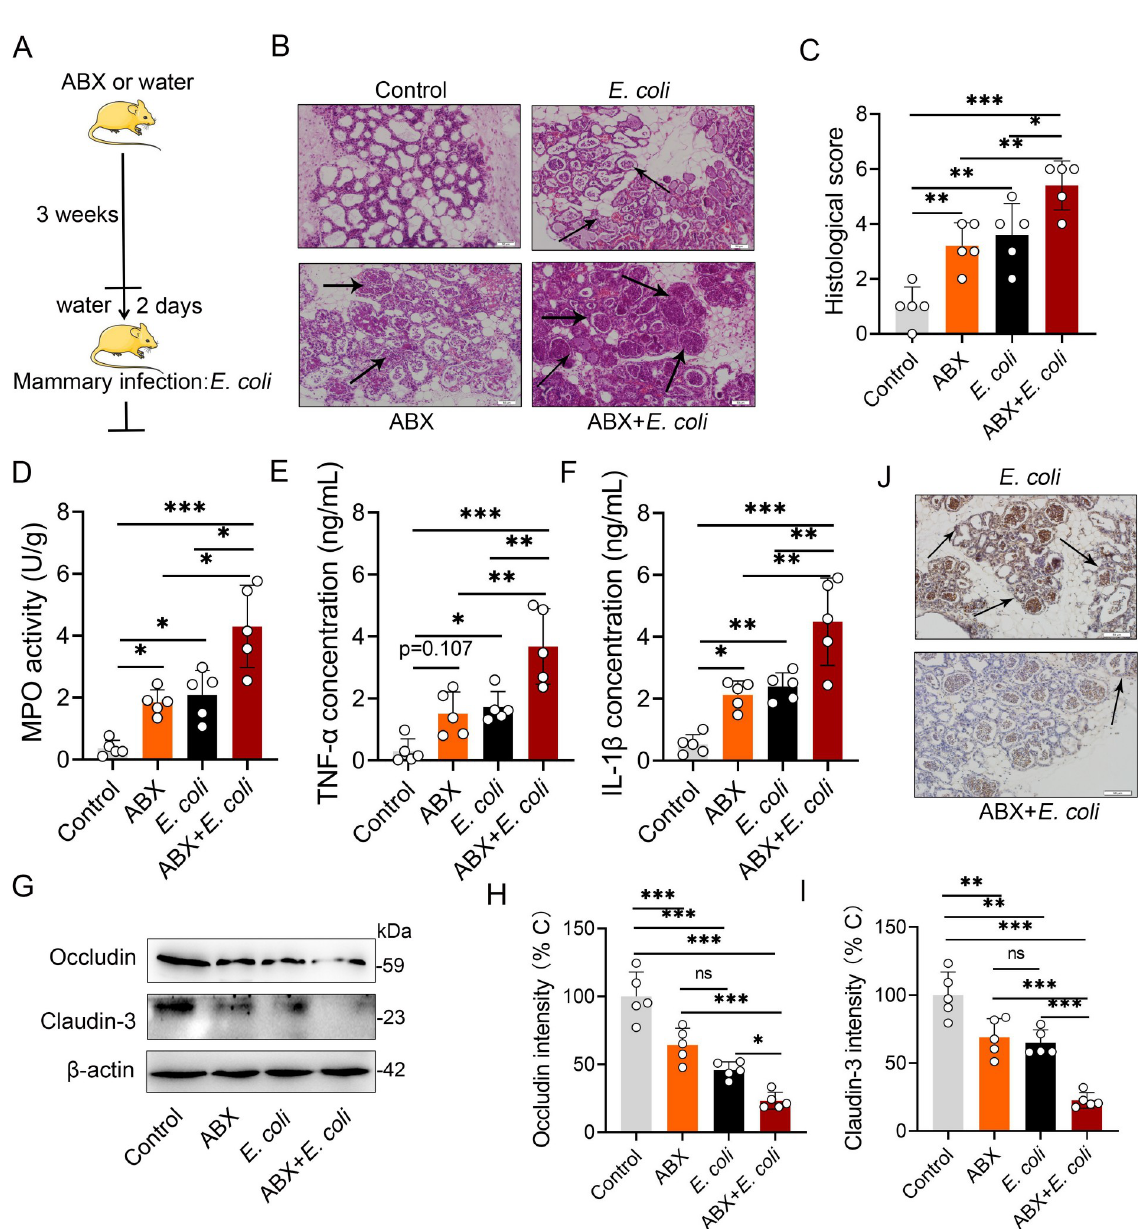
Fig 4. Gut dysbiosis aggravates E . coli -induced mastitis. (A) Schematic representation. The mice were treated with ABX (1 g/L ampicillin, neomycin sulfate and metronidazole and 0.5 g/L vancomycin) for 3 weeks, and ABX was removed for 2 days before mastitis was induced by E . coli . ( B) Representative H&E staining of mammary gland tissue sections employed in histological analysis. The black arrow indicates inflammatory cells infiltration (scale bar, 50 μ m). ( C) Histological score according to H&E staining sections (n = 5). MPO activity ( D), TNF- α ( E ) and IL-1 β ( F ) were measured using ELISA on different groups mice (n = 5). Levels of occludin and claudin-3 protein ( G ) and intensity analysis ( H-I ) (n = 5). ( J) Representative occludin antibody stained mammary gland sections (scale bar, 50 μ m). The black arrow indicates positive staining. � p < 0.05, �� p < 0.01 and ��� p < 0.001 indicate significant differences from each group. ns, no significance. One-way analysis of variance was performed and the data are presented as the means ± SEM (C–F and H-I). ABX, a cocktail of antibiotics.